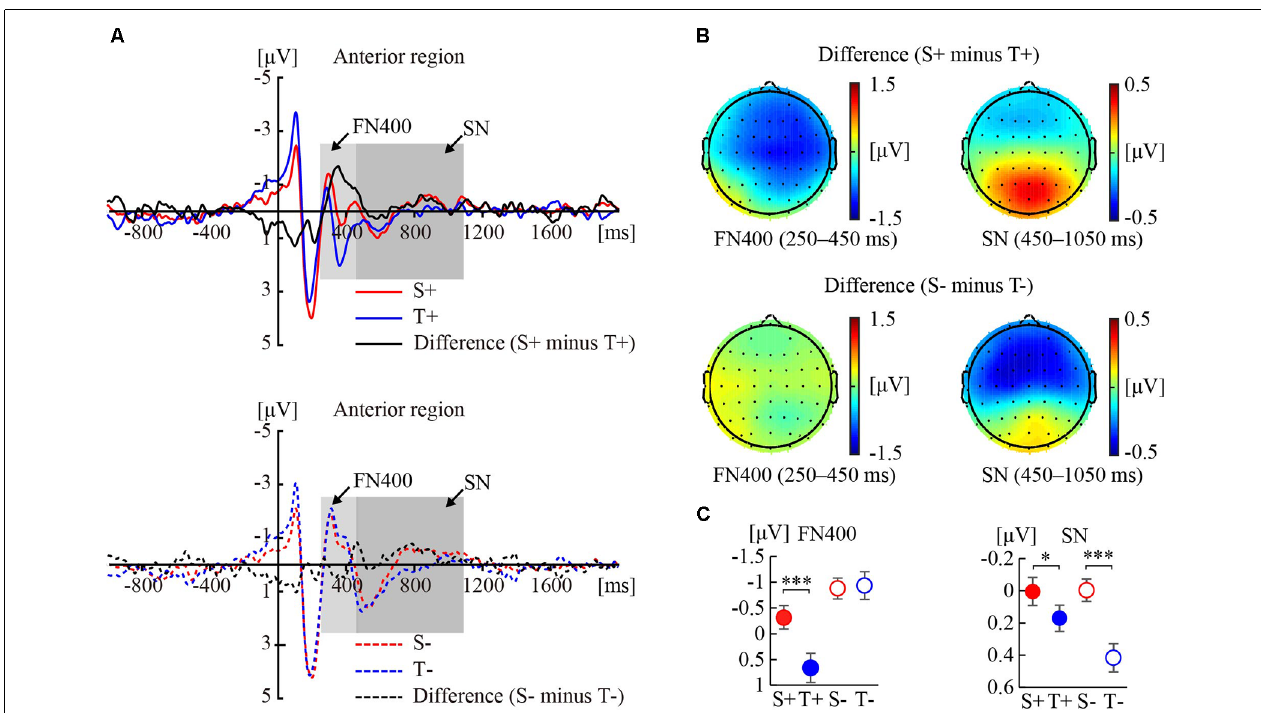
FIGURE 1 | Event-related potential (ERP) responses to the premise monotonicity effect. (A) Grand-averaged waveforms elicited by S+ and T+ arguments and the difference waveform (S+ minus T+) in the anterior region (top); grand-averaged waveforms elicited by S − and T − arguments and the difference waveform (S − minus T − ) in the anterior region (bottom). (B) Topographies of the difference waveforms of FN400 in the 250–450 ms interval and sustained negativity (SN) in the 450–1,050 ms interval. (C) Statistical comparisons of premise monotonicity (S, T) and conclusion congruency ( + , − ) in the average amplitudes of FN400 and SN. Error bars indicate the standard error of the mean (SEM). ∗ p < 0.05; ∗∗∗ p < 0.001 for the comparison of